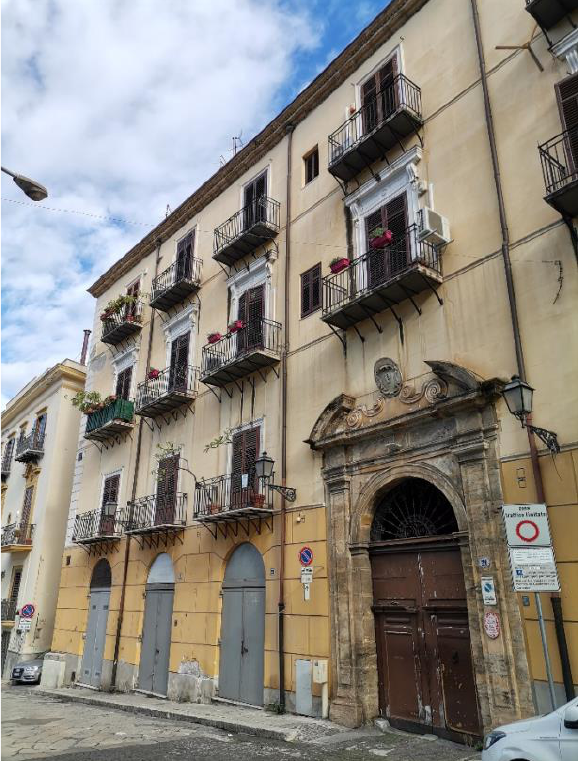
Figure 3: Low Image resolution of the façade of an ancient building.